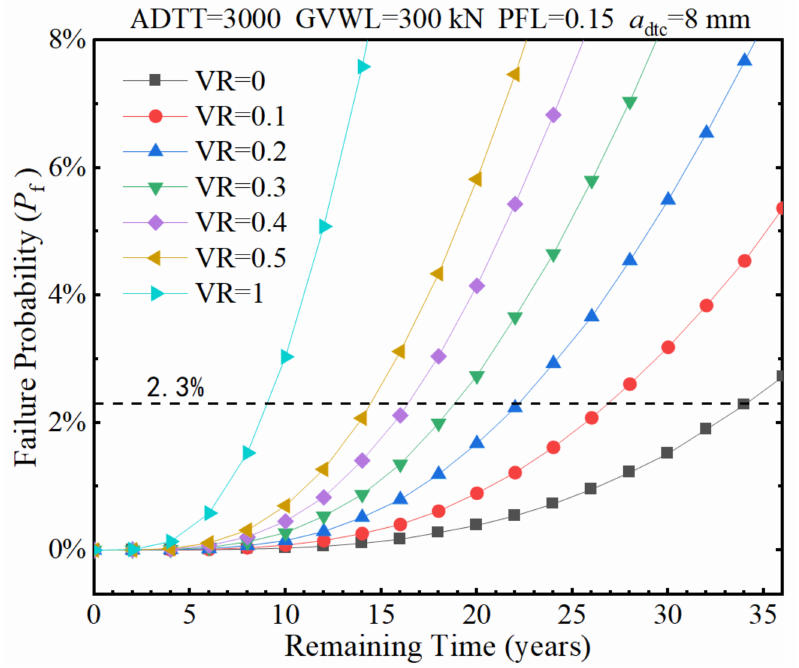
Figure 20. Failure probability of the fatigue detail under various VRs when the GVWL equals 300